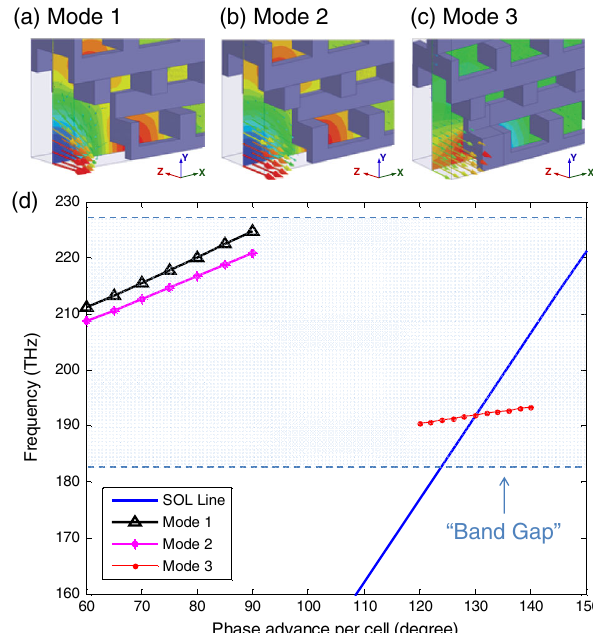
FIG. 8. New TM-like propagating modes of different woodpile waveguide channel dimensions, with their vector electric fields plotted in (a) mode 1, (b) mode 2, and (c) mode 3, and dispersion curves plotted